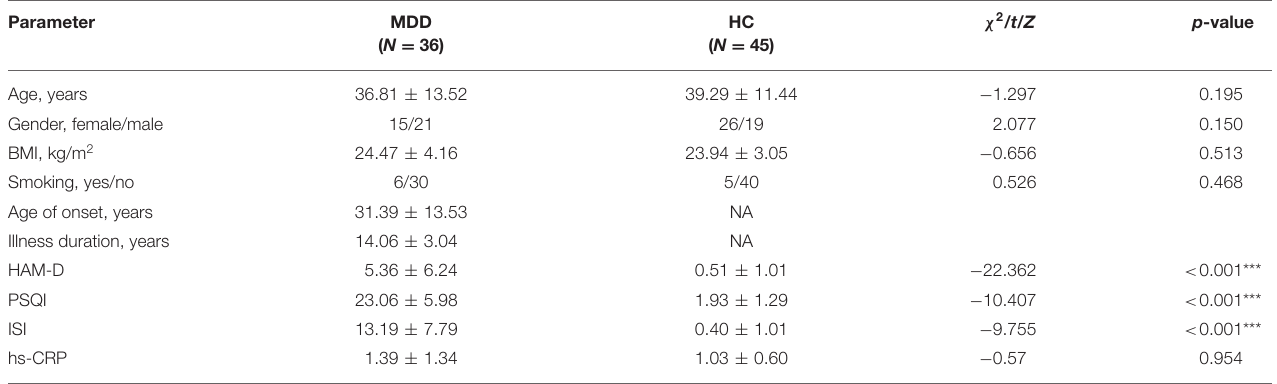
TABLE 1 | Demographic and clinical characteristics in MDD patients and HC.